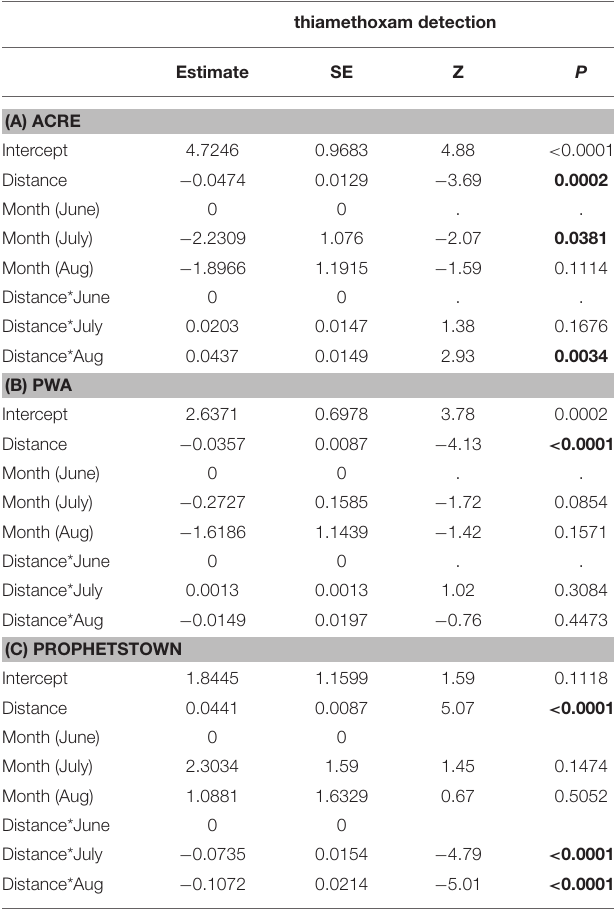
TABLE 5 | The effects of month and distance separating focal plants from the nearest cropland on thiamethoxam detection associated with milkweed leaves at three sites (A–C) sampled in